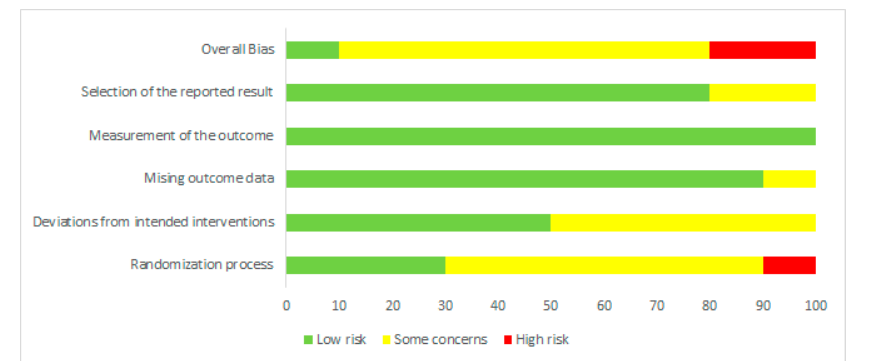
Figure 2. Risk of bias summary: review authors’ judgements about each risk of bias item for each included study.